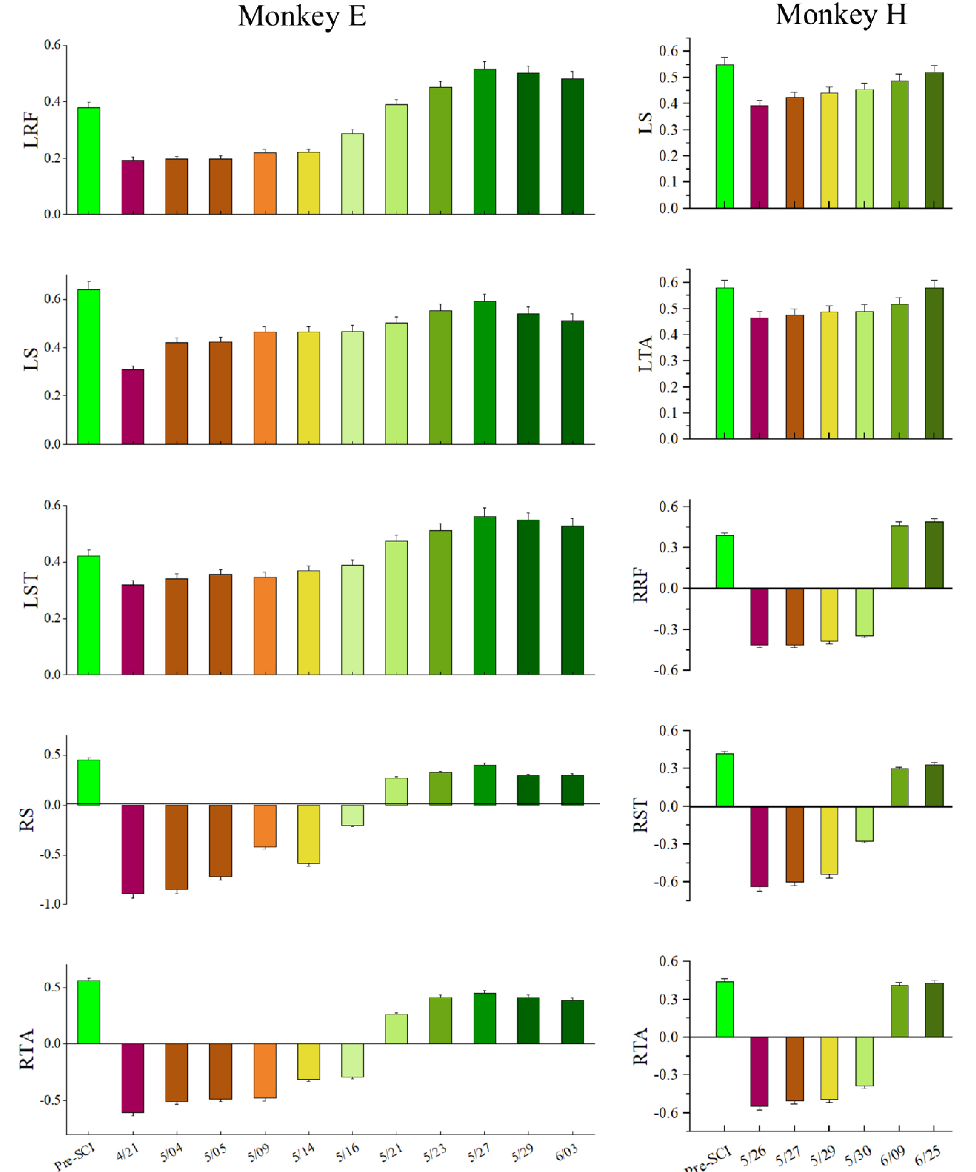
Figure 10. Decoding performance during each session (day). The error bar on each bar graph represents the